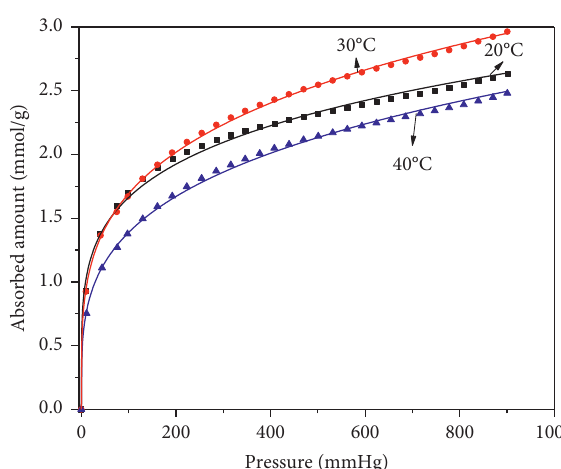
Figure 11: Carbon monoxide adsorption isotherms of 2CuCl/ diatomite at different temperatures.